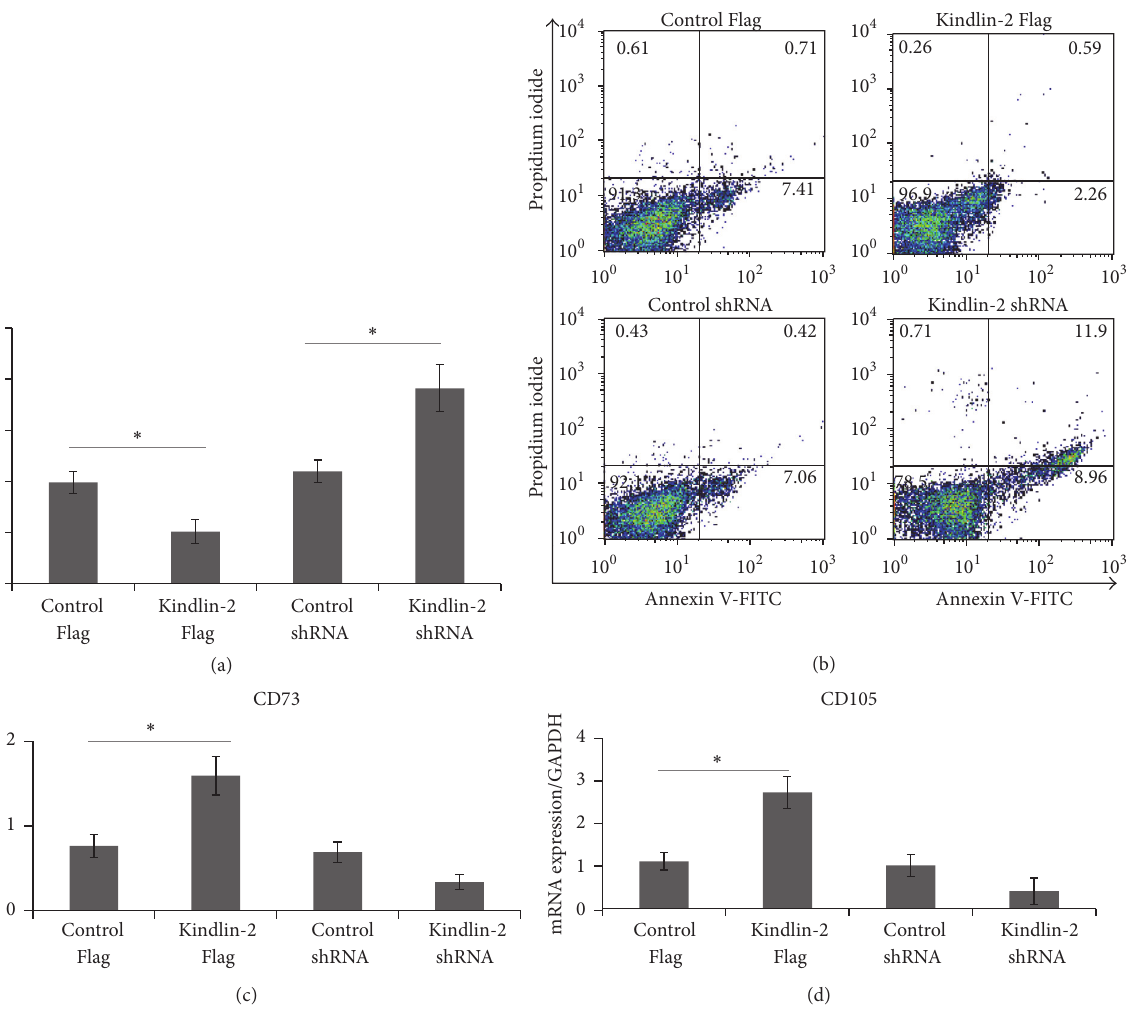
Figure 3: Kindlin-2 regulates apoptosis and stem cell markers in iPSC-MSCs. The iPSC-MSCs were stained using annexin V and propidium iodide for analyzing cell apoptosis after transfection with Kindlin-2 constructs and quantified for early and late apoptotic cells. Kindlin-2 knockdown significantly increased apoptotic cells while Kindlin-2 overexpression significantly decreased apoptotic cells compared to control Flag (a). Data were presented as the mean ± SEM from three independent experiments. Dot plots showing single experiments for annexin V/propidium iodide double positive cells for late apoptotic cells (b). (c) and (d) show quantitative RNA expression of the MSC stemness markers CD73 and CD105 in Kindlin-2 overexpressing and knockdown cells and their controls, respectively. Numbers in (b) indicate % cells in quadrant gate. ∗ Significance difference 𝑝 ≤ 0.05